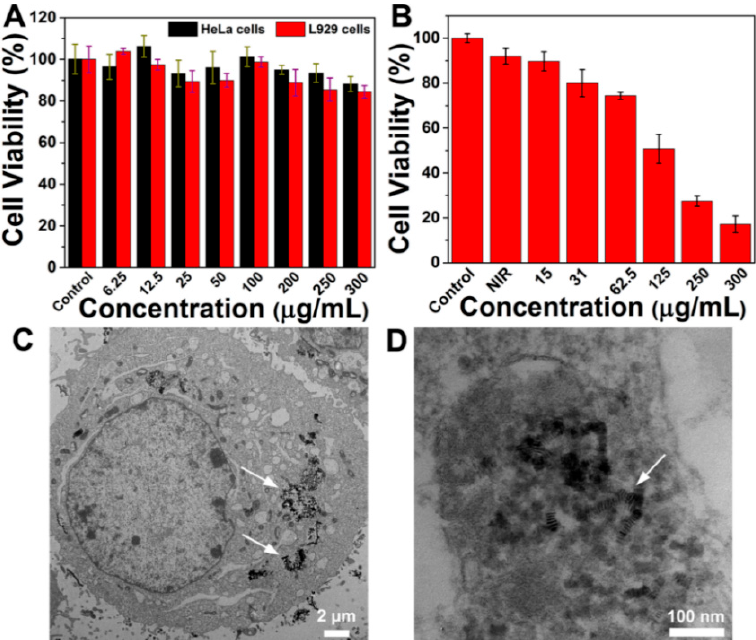
Figure 3. ( A ) In vitro cytotoxicity assays of NV-p@BSA NPs at various concentrations against HeLa and L929 cells. ( B ) Photo-induced cytotoxicity of NV-p@BSA samples plus the 808 nm laser irradiation (0.8 W cm − 2 , 5 min) towards HeLa cells. ( C , D ) TEM images of HeLa cells incubated with NV-p@BSA NPs for 4 h. The white arrows indicate the locations of NV-p@BSA NPs within the